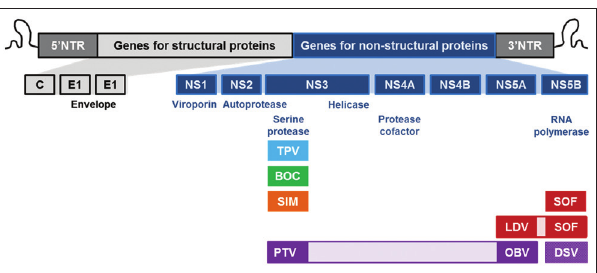
Figure 2) Hepatitis C virus genome and the polyprotein targets of